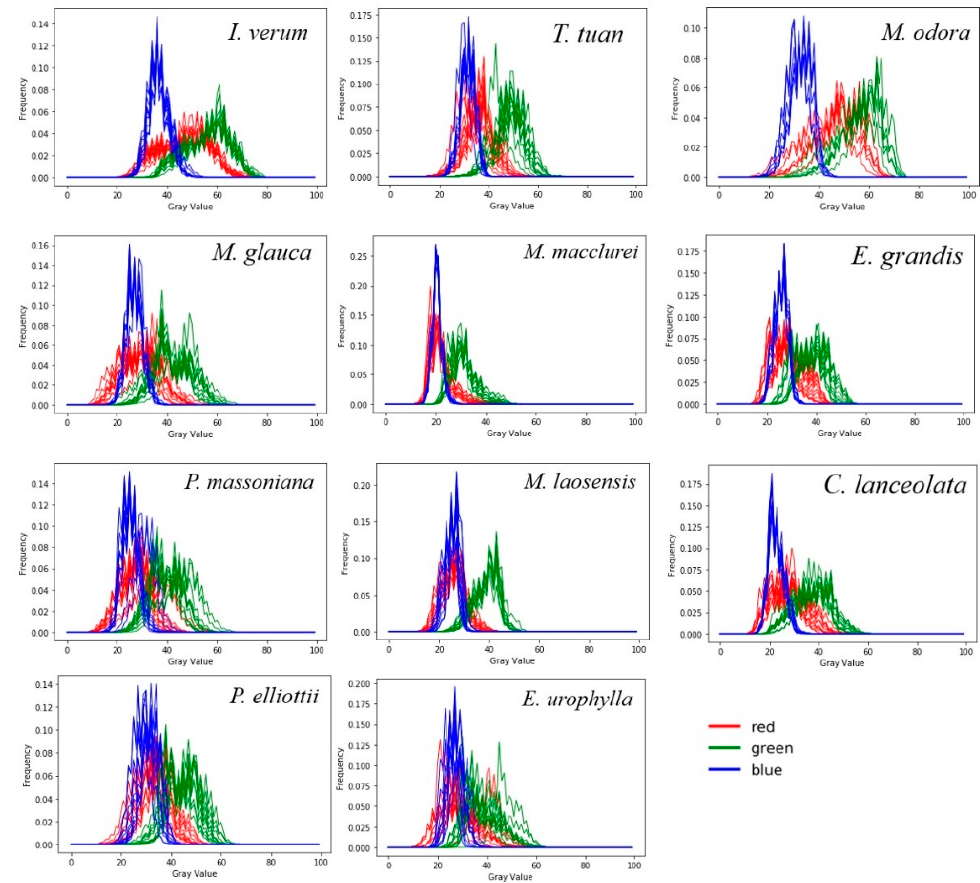
Figure 11. The histograms of 11 tree species in the R, G, B bands.